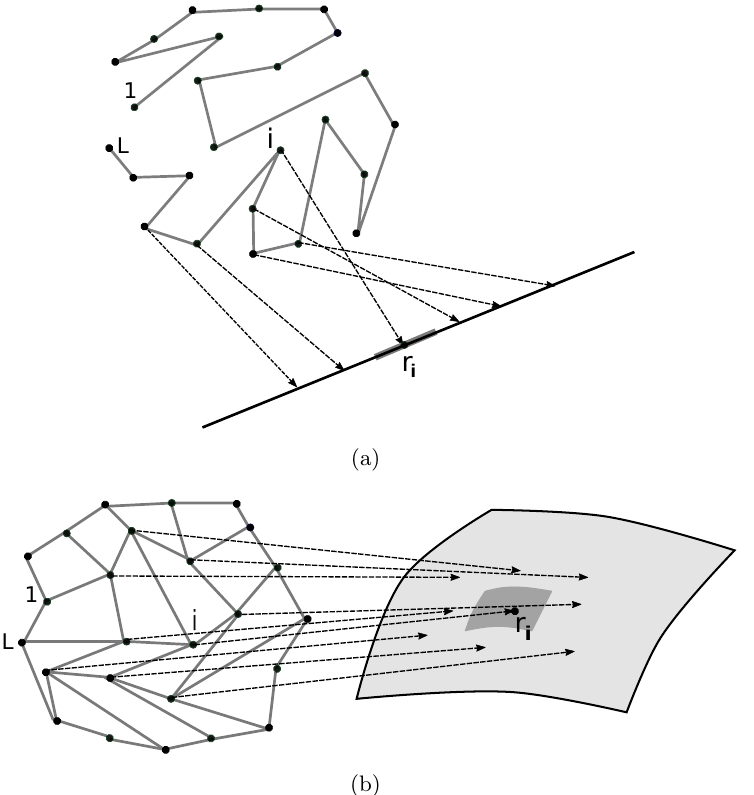
Figure 4 . The panels (a) and (b) represent states in eq. (2.8) with local structures given by eq. (2.10) and eq. (2.12), respectively. In the (cid:12)gures on the left, the dots represent sites in a frame, and the links represent entanglement bonds formed by bi-local collective variable, t ij . The dashed lines represent mappings from sites to manifolds. In the (cid:12)gures on the right, the grey area around r i denotes the region of coordinate volume V i assigned to site i in the manifold. The dimension and topology of the manifold in which the local structure is manifest are determined from the pattern of entanglement bonds. In the large L limit, the proper distances between sites 1 and L in states (a) and (b) scale as O( L ) and O(1) respectively due to di(cid:11)erent local entanglement